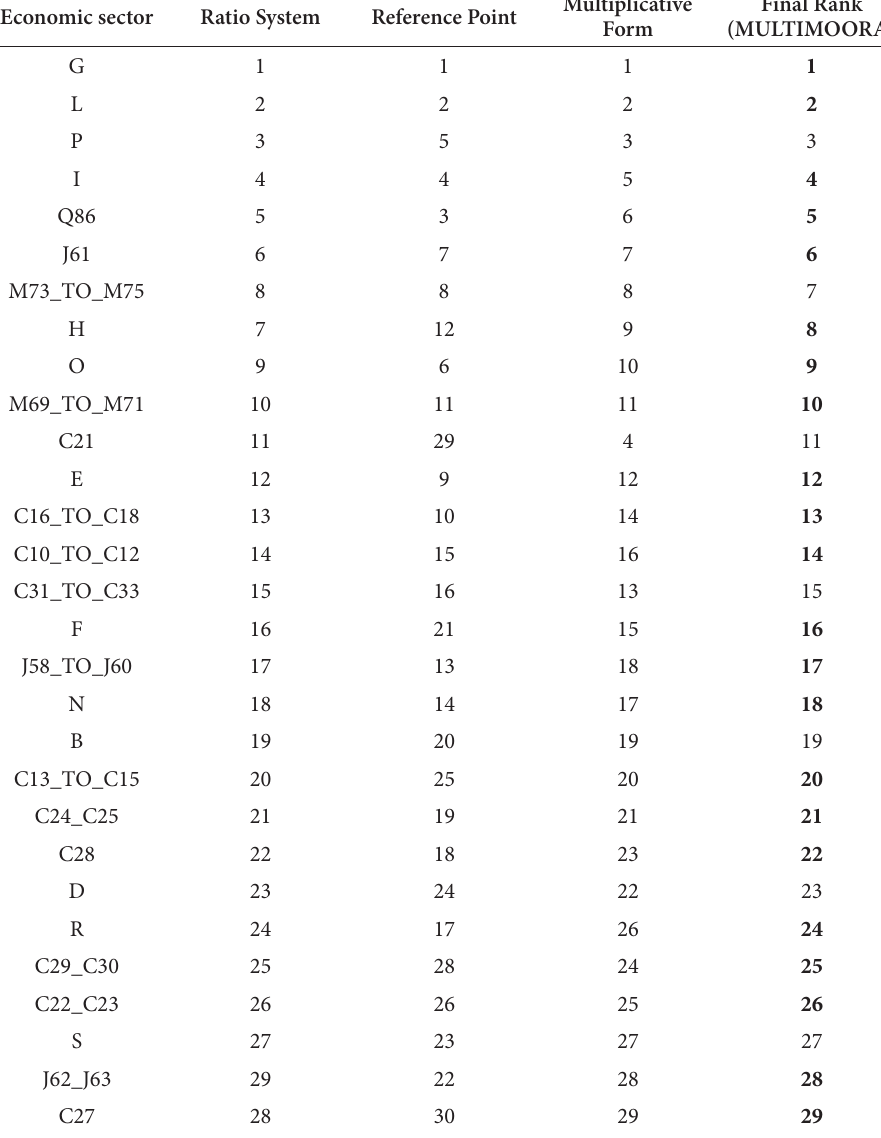
Table 1. Ranks of the economic sectors provided by the different parts of the MULTIMOORA method Economic sector Ratio System Reference Point